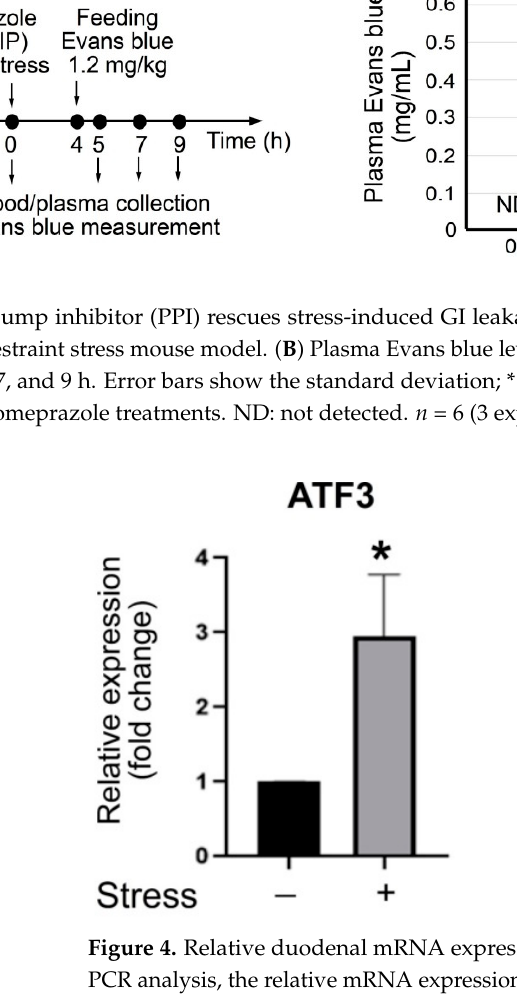
Figure 5. An ATF3 deficiency exacerbates stress ‐ induced GI injuries and claudin 3 (CLDN3) suppression. ( A ) Plasma Evans blue levels of WT (WT) and ATF3 gene knockout (KO; ATF3 − / − ) mice with or without stress at 0, 5, 7, and 9 h. ( B , C ) Flow cytometry analysis of tight junction protein CLDN3 expressing gut epithelial (CD326 + /CLDN3 + double positive) cells in WT ( B ) and ATF3 − / − ( C ) mice. ( D , E ) The quantitative results of flow cytometry CD326 + /CLDN3 + populations in WT ( D ) and ATF3 − / − ( E ) mice are indicated. ( A ) # p < 0.05 and ## p < 0.01 vs. their respective WT groups and ( A – E ) * p < 0.05, ** p < 0.01 vs. no stress groups; error bars show the standard deviation. ( A ) n = 6 (3 experiments with a total of 6 mice per group) and ( B – E ) n = 4 (2 experiments with a total of 4 mice per group).